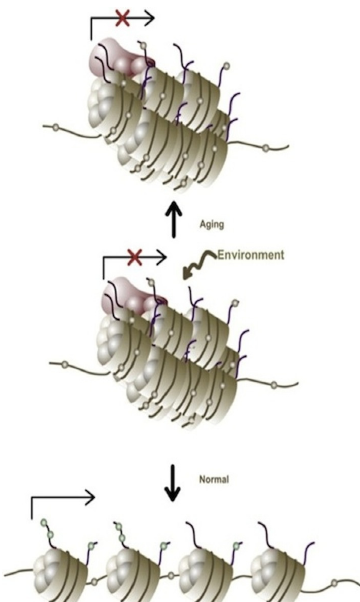
Figure 4. Loss of the normal genetic plasticity with aging: if a gene undergoes environmental-dependent epigenetic change, the ability to respond and revert this modification could be reduced because of aging, and the gene may be repressed (Source: Marques et al.